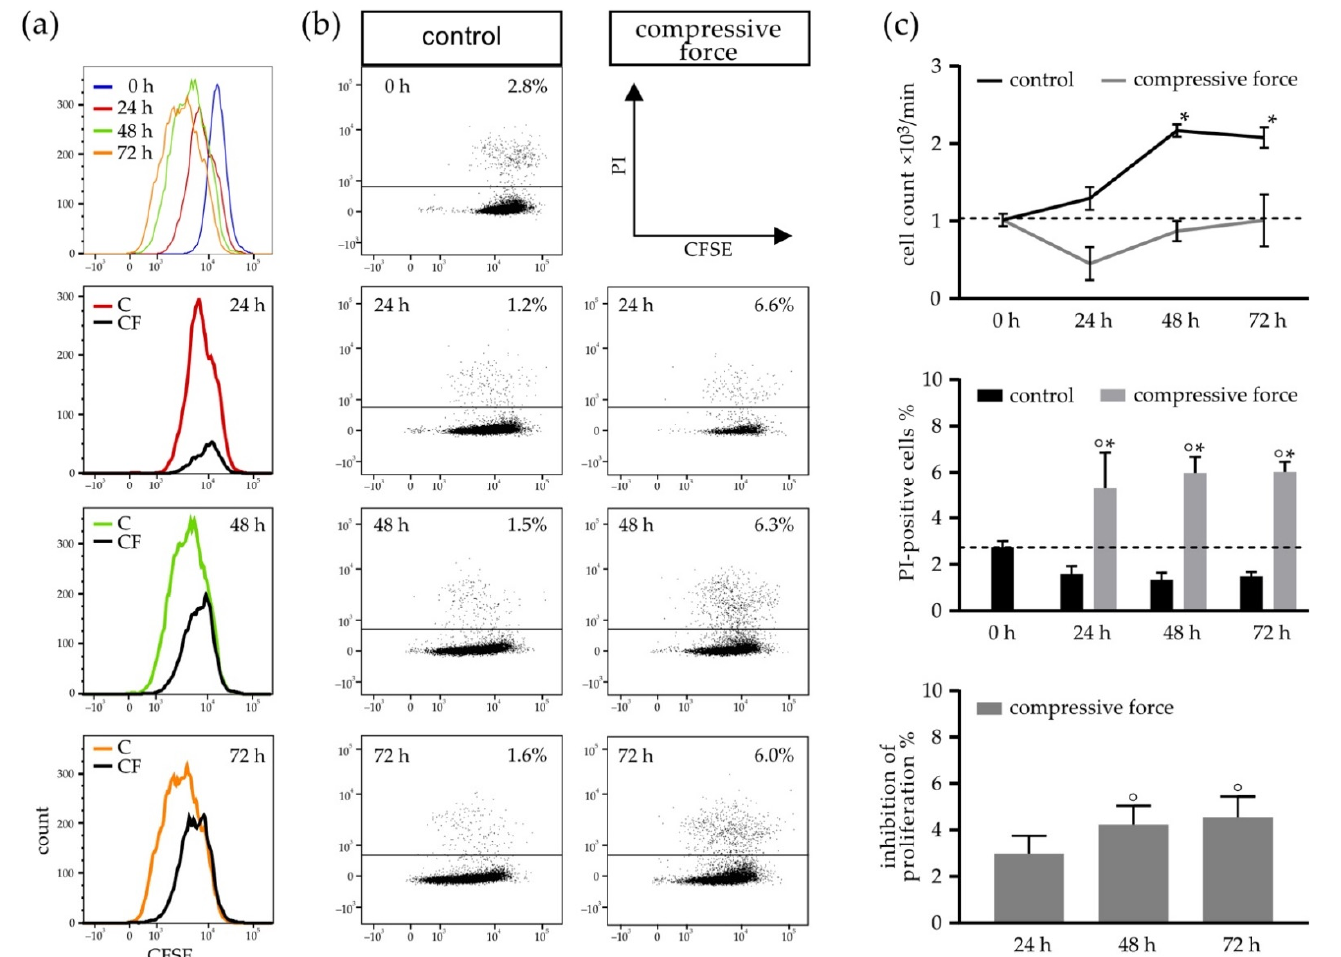
Figure 3. Disparities in CFSE–PI-stained hPDLFs between the control (C) and compressive force groups (CF) in terms of the cell count, PI-positive cells (dead cells) and inhibition of proliferation measured by flow cytometry. Data shown is representative for the CFSE–fluorescence intensity and inhibition of proliferation in the CF ( a ) and CFSE-positive and CFSE/PI-positive events ( b ). ( c ) Evaluation of the flow cytometry results in terms of the cell count, percentage of PI-positive cells and inhibition of proliferation. Bars indicate the mean values ± standard deviation. A p -value < 0.05 was considered statistically significant. (*) Comparison of the 24-h, 48-h and 72-h (C and CF) time points with the 0-h control. ( ◦ ) Comparison of the CF with the respective control of the time point.